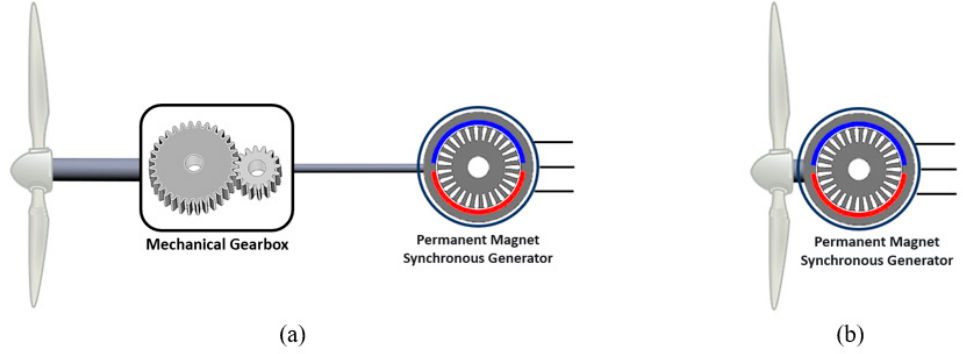
Figure 14. Powertrain of a wind turbine: ( a ) Conventional scheme: mechanical indirect drive; ( b ) Traditional direct drive.